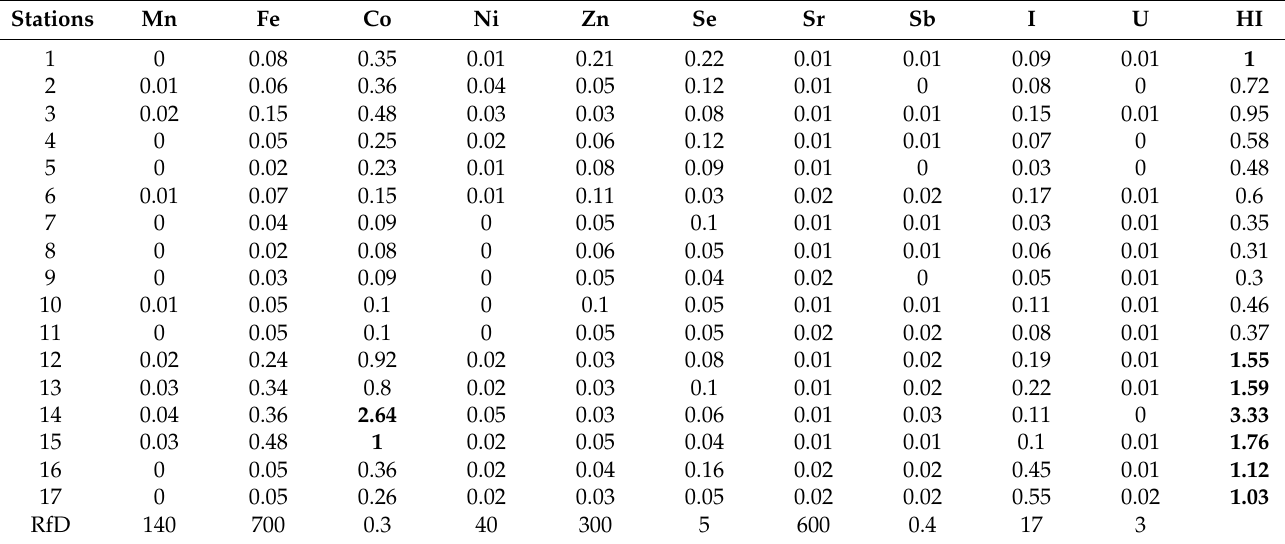
Table 4. Target hazard quotients and hazard indices from Namibia to Mozambique based on